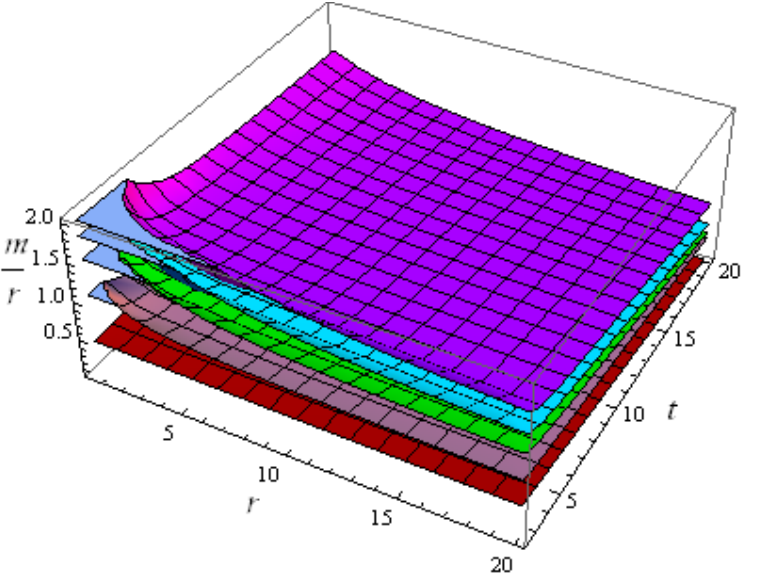
Figure 1. Plots of m for α = 0 (Red), α = 1 (Pink), α = 3 (Green), α = 5 (Cyan) and α = 7 r